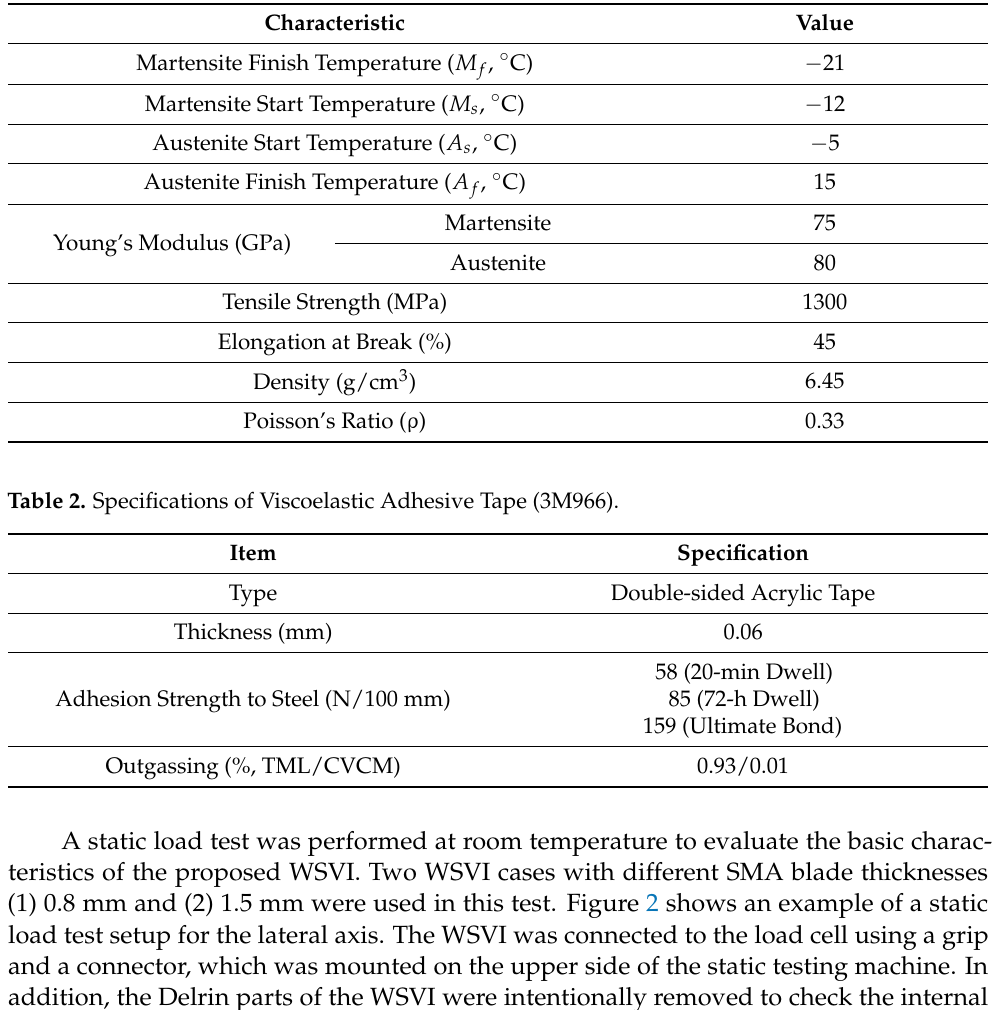
Table 1. Material Properties of the Superelastic SMA.